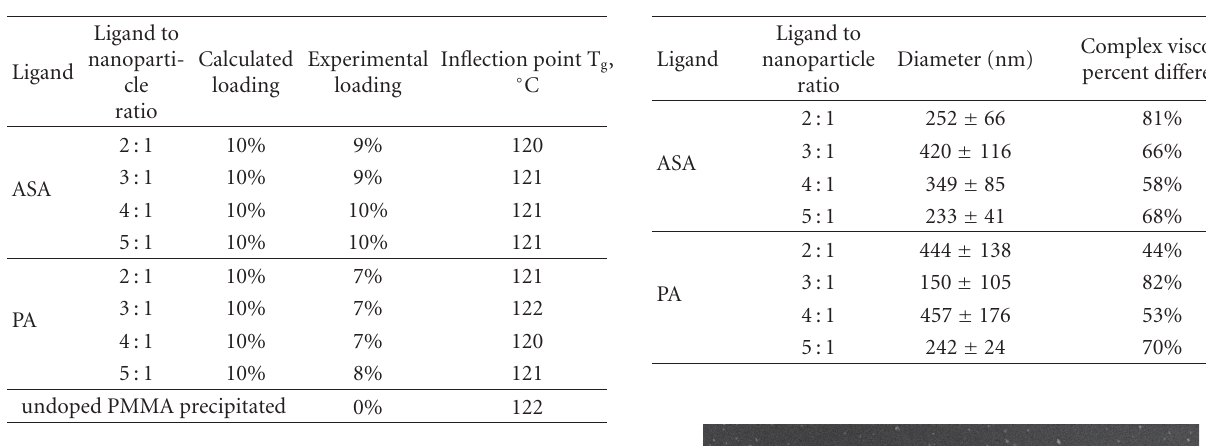
Table 1: Percent loadings and glass transition temperature of ligand capped nanocrystals in PMMA.